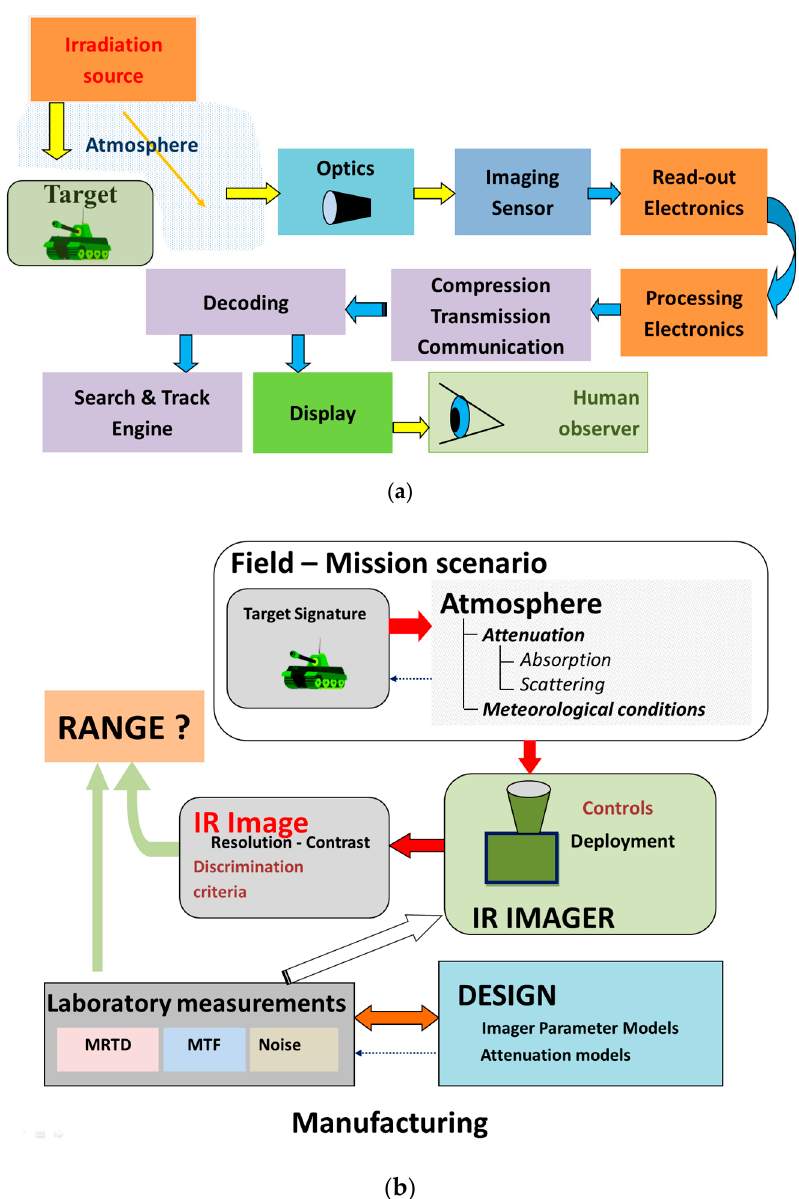
Figure 2. Imager range influences: ( a ) Image forming chain; ( b ) thermal imager range prediction data sources and their interconnection.